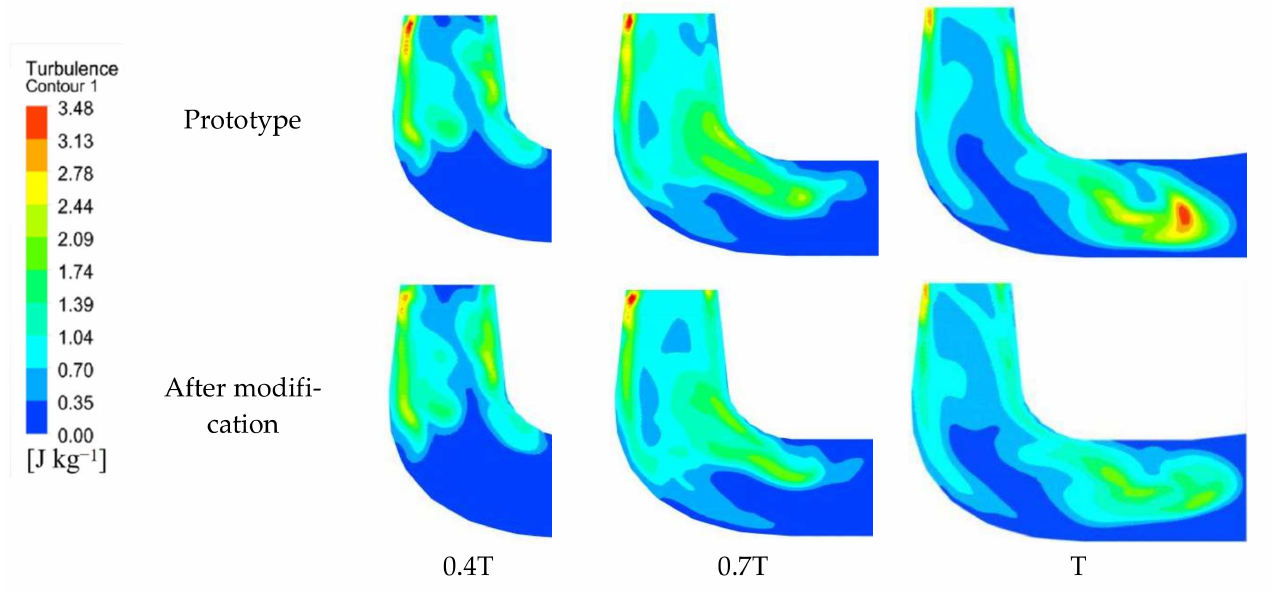
Figure 12. Comparison of turbulent energy evolution of draft tube before and after changing airfoil